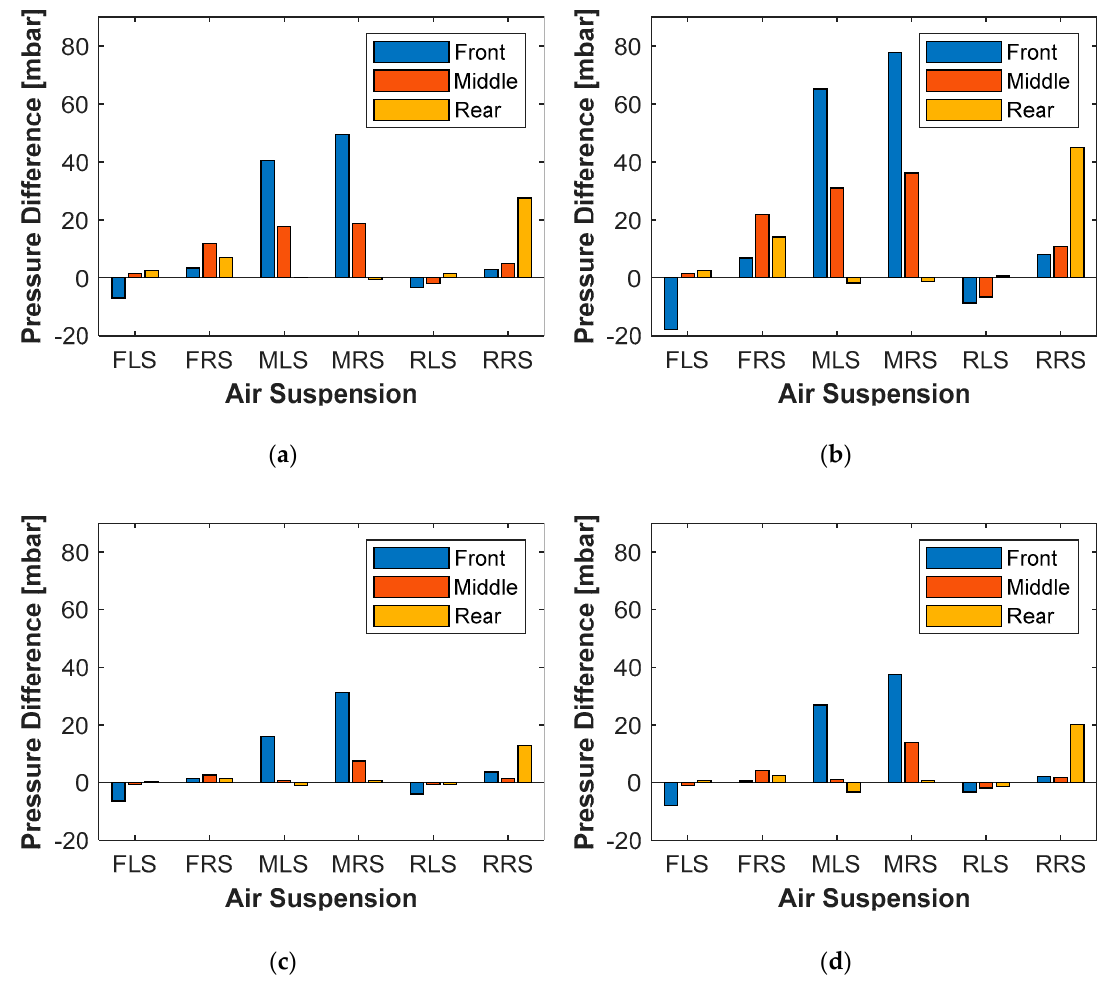
Figure 11. Resulting pressure changes in the respective air suspensions for two loads and conditions. ( a ) Seventy kilograms, leveled. ( b ) One-hundred-and-five kilograms, leveled. ( c ) Seventy kilograms, lowered. ( d ) One-hundred-and-five kilograms, lowered.